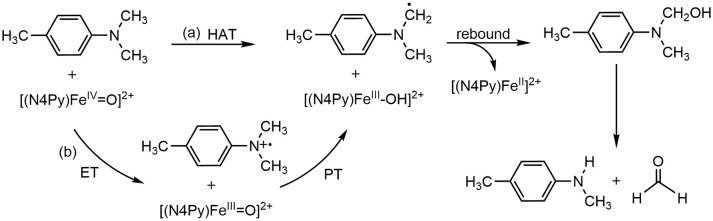
ET-PT(SET) and HAT mechanism in the para-substituted N,N-dimethylanilines activated by [(N4Py)-FeIV = O](ClO4)2.